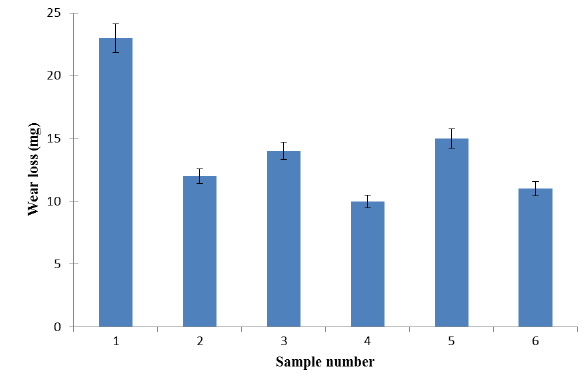
Figure 15: Variation of wear loss for all